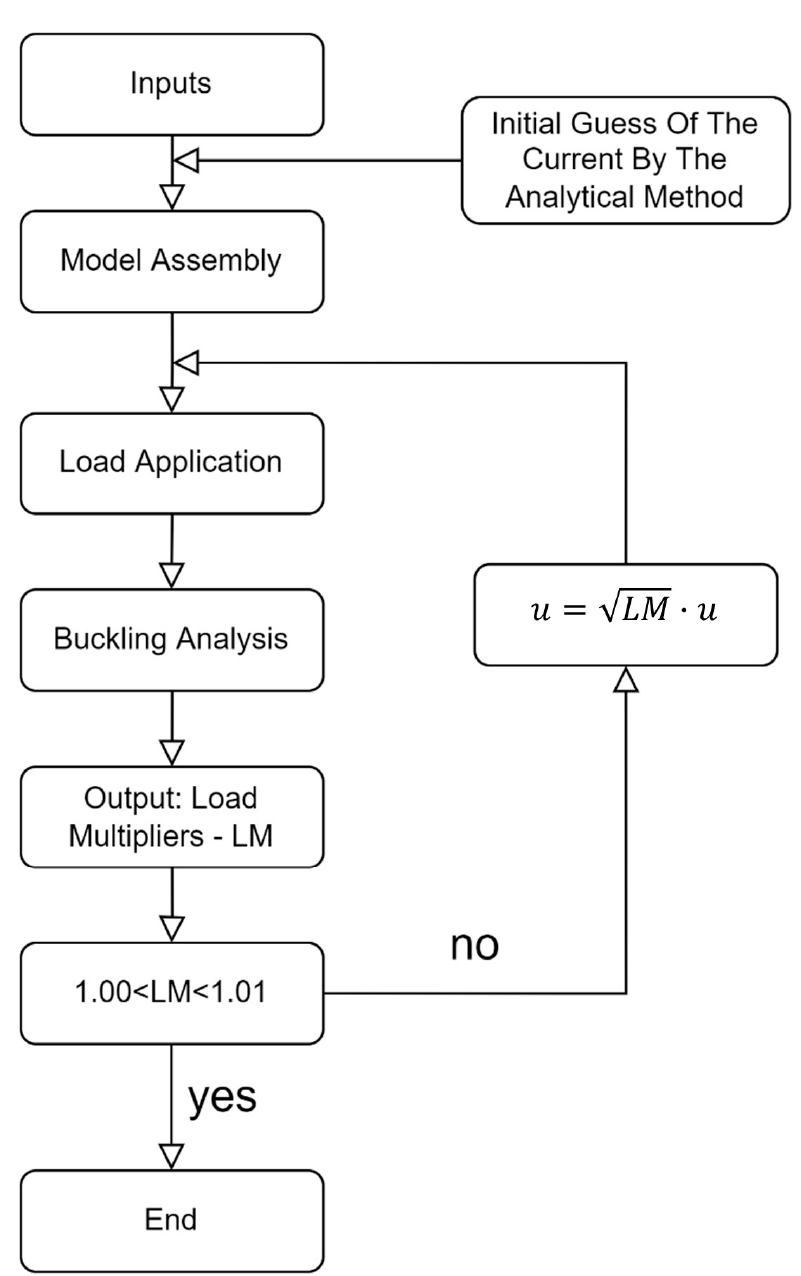
Figure 8. Flow chart of the iterating procedure to solve the critical buckling velocity, by the APDL model.